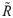
Average RCA weights per box.For each box b we plot a histogram showing the average R˜ values of countries exporting the products contained in b. Each bar of the histograms shows the average RCA of countries with a Fitness value between two consecutive deciles of the Fitness distribution. We remind that R˜ represents the share of a product in a country’s total exports. The distributions on the minima of H, which correspond to the asymptotic market shape of the market, go from flat for the lowest Complexity level to markedly peaked on high Fitness for the highest Complexity, and are highlighted in red. Most of the high-Complexity products are found between the asymptotic zone and the top of the plane, and they show a distribution of comparative advantage that is markedly peaked on high-Fitness countries. More interesting is the case of low-Complexity products, that are mostly found between the asymptotic zone and the bottom of the plane. Here the asymptotic market market shape is either rather flat or gently peaked on low-Fitness countries.